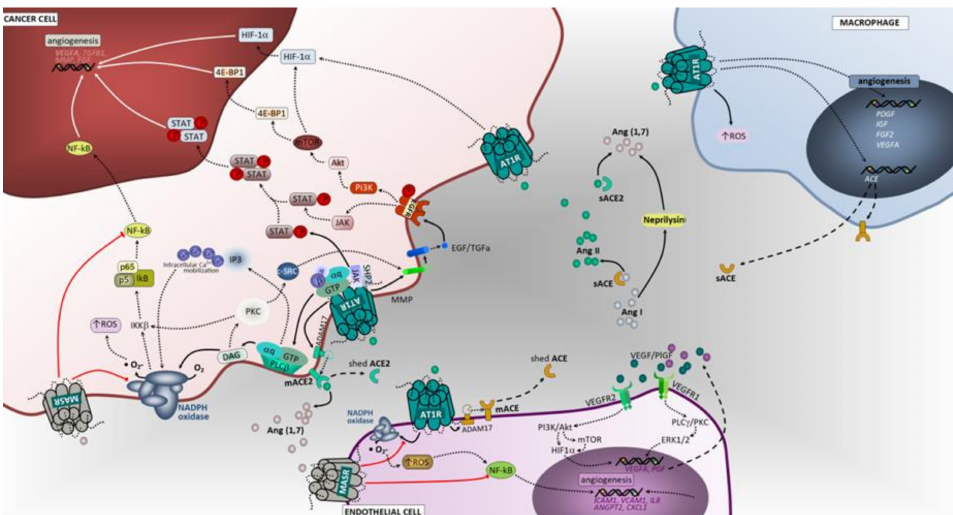
Figure 3. Angiotensin-associated pathways involved on hypoxia and angiogenesis in lung tumor microenvironment. In cancer cells, upon binding of Ang II to AT1R, a pleiotropic downstream signaling cascade is triggered, ultimately causing, either directly or indirectly, upregulation of angiogenesis and metastasis. Activated AT1R subunits trigger potent oxidant signaling through NADPH complex, which is involved in angiogenesis. Activated G α q / 11 units also activate the JAK-SHP2 / STAT pathway and receptor tyrosine kinase (RTK) transactivation. Subsequent signaling upon activation of EGFR is herein represented. Macrophages, endothelial cells and fibroblasts are important components of the tumor microenvironment and capable of generating and expressing RAS components. These cells, beyond their functional ligands and receptors that are altered in tumor microenvironment, and reflect the crosstalk between all cell constituents, also use the RAS signaling pathway (mostly AT1, but also MasR in endothelial cells) to yield functional characteristics that ultimately may favor the cell itself and enhancing tumor angiogenesis and metastasis. 4E-BP1, Eukaryotic translation initiation factor 4E-binding protein 1; IKKB, Inhibitor of nuclear factor kappa-B kinase subunit beta; c-SRC,